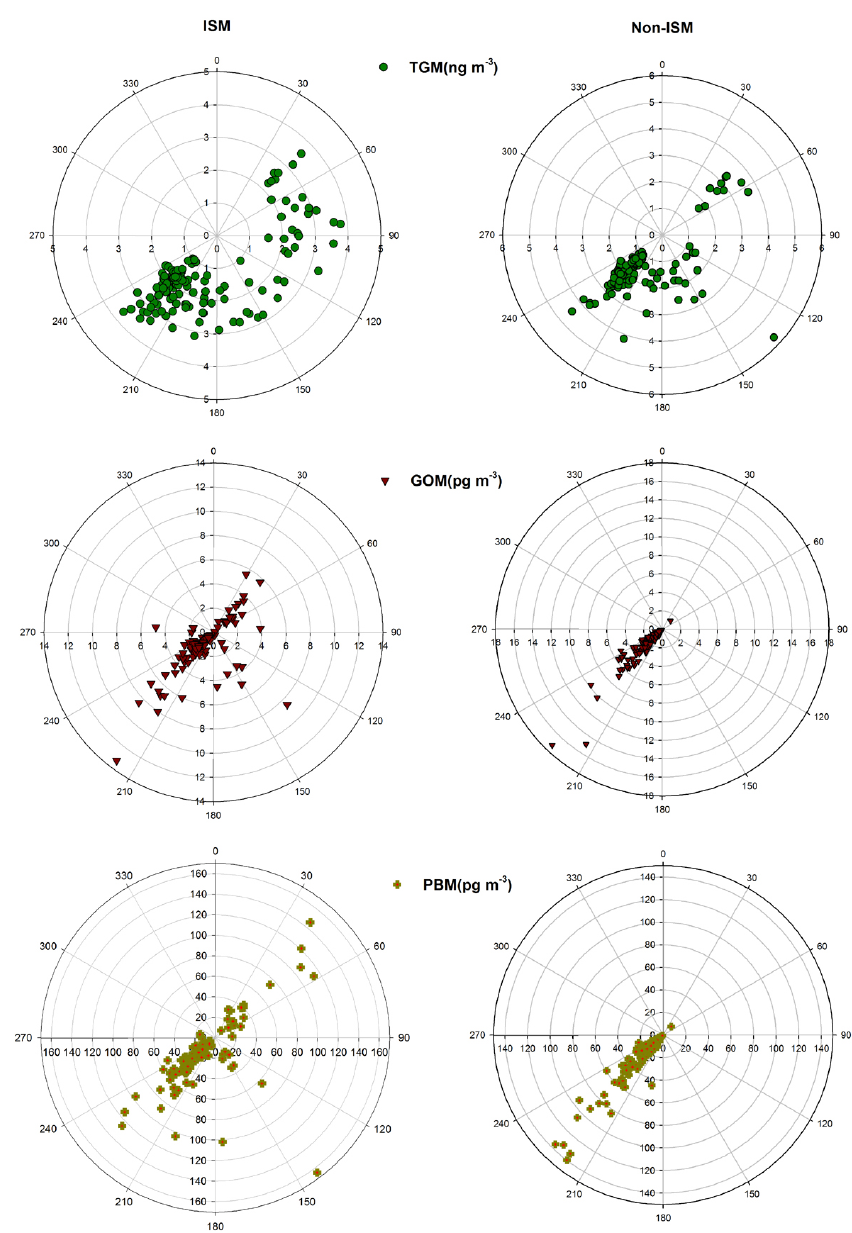
Figure 6. Pollution roses of Hg species. Most of the TGM, GOM and PBM were from SW, and some higher TGM, GOM and PBM events were from NE during the ISM period. Almost all TGM, GOM and PBM were from SW during the non-ISM